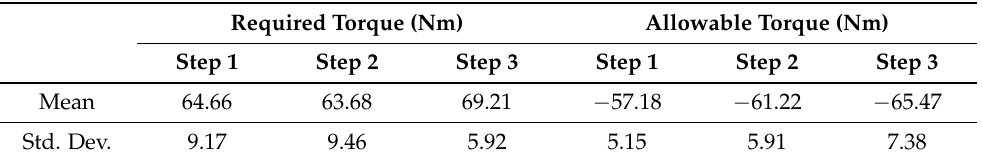
Table 3. Statistical analysis of variation in difference of required and allowable torque on front wheels during controlled and uncontrolled conditions with respect to the change in the height of a step.